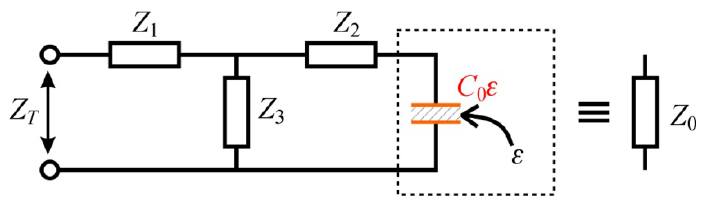
Figure 4. Four-pole T model of the open-ended coax sensor.